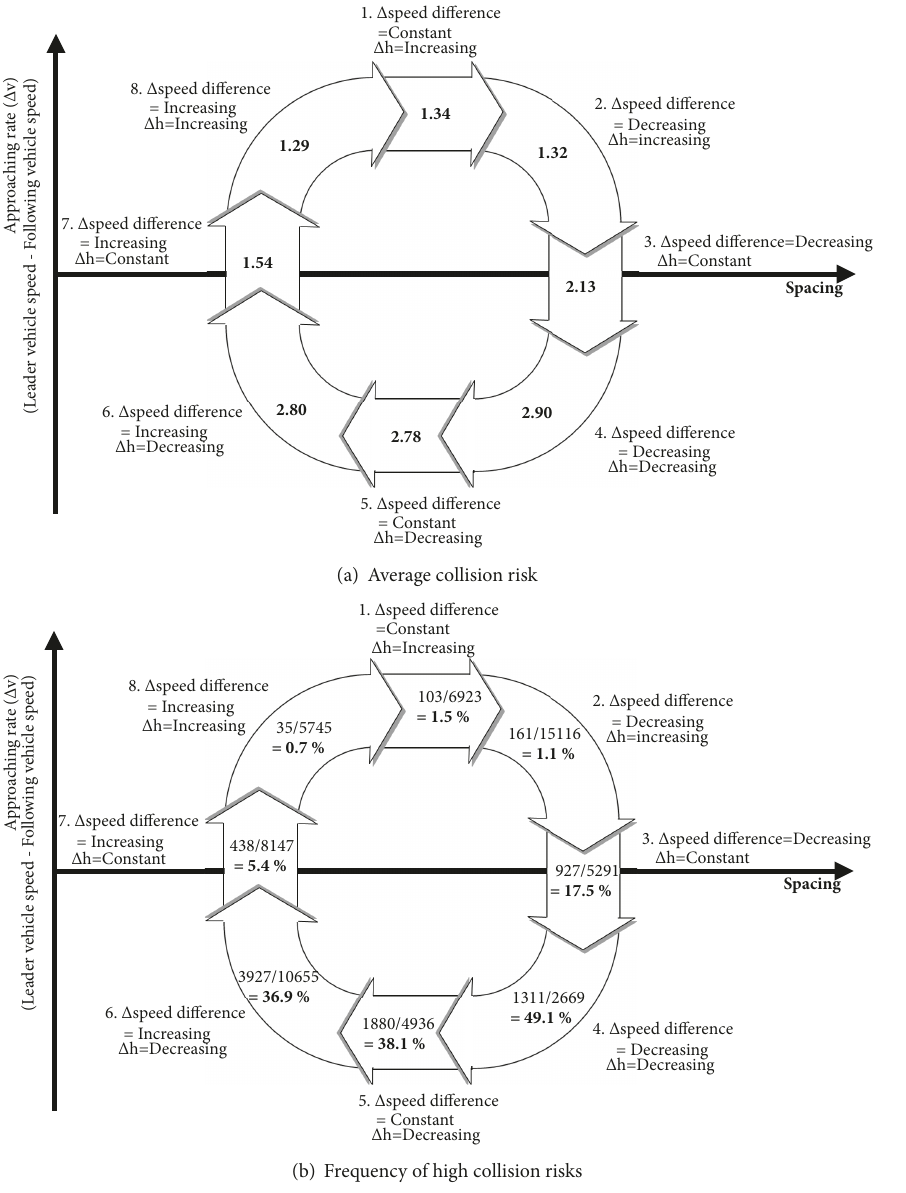
Figure 7: The SHD trends on the average collision risk and frequency of high collision